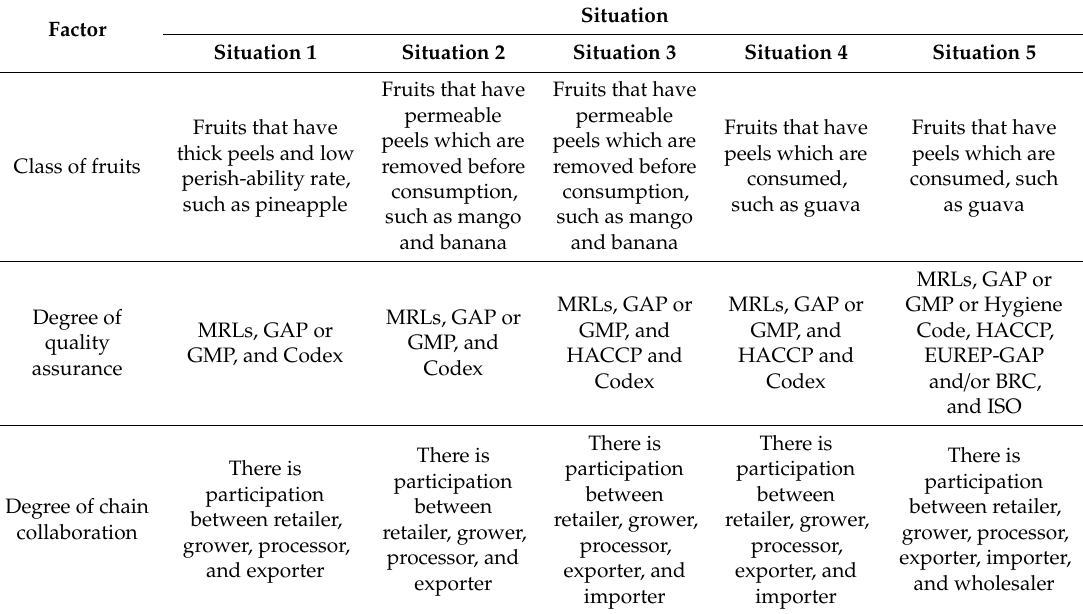
Table 5. Representatives of situations in the fruit chains as a tool to assess situations in